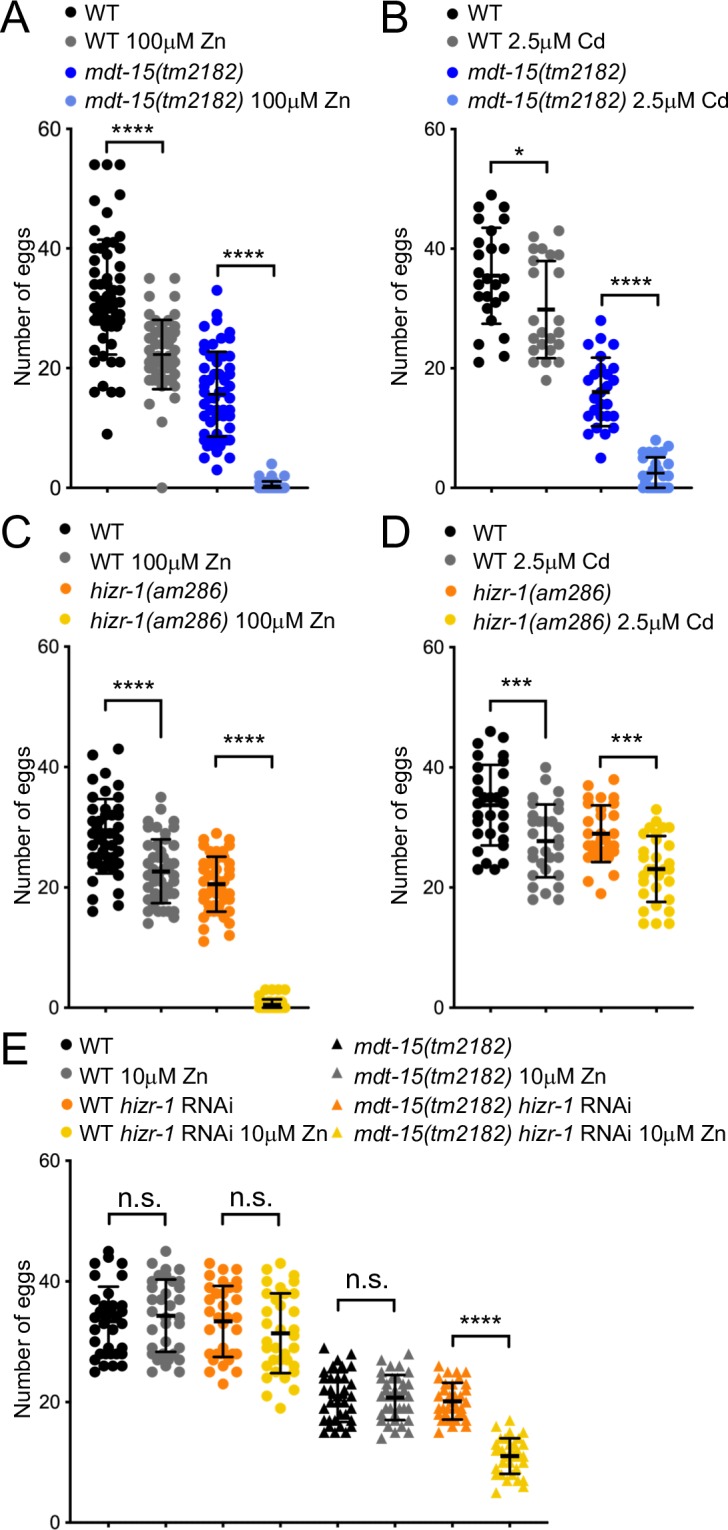
Loss of mdt-15 renders worms sensitive to cadmium and zinc.[A] The graph shows the average number of eggs laid over a 24-hour period by WT worms and mdt-15(tm2182) mutants grown on 0μM and 100μM zinc (Zn). Each dot represents progeny from an individual worm (WT 0μM Zn: n = 59; WT 100μM Zn: n = 56; mdt-15(tm2182) 0μM Zn; n = 57; mdt-15(tm2182) Zn: n = 51; from 3 independent repeats). Error bars: standard deviation; statistical analysis: **** p < 0.0001, Two-way ANOVA, multiple comparisons; Tukey correction. [B] The graph shows the average number of eggs laid over a 24-hour period by WT worms and mdt-15(tm2182) mutants grown on 0μM and 2.5μM cadmium (Cd). Each dot represents progeny from an individual worm (WT 0μM Cd: n = 25; WT 2.5μM Cd: n = 23; mdt-15(tm2182) 0μM Cd: n = 26; mdt-15(tm2182) on 2.5μM Cd: n = 27; from 3 independent repeats). Error bars: standard deviation; statistical analysis: **** p < 0.0001, * p < 0.05, Two-way ANOVA, multiple comparisons; Tukey correction. [C] The graph shows the average number of eggs laid over a 24-hour period by WT worms and hizr-1(am286) mutants grown on 0μM and 100μM zinc (Zn). Each dot represents progeny from an individual worm (all groups n = 46; from 2 independent repeats). Error bars: standard deviation; statistical analysis: *** p < 0.001, **** p < 0.0001, Two-way ANOVA, multiple comparisons; Tukey correction. [D] The graph shows the average number of eggs laid over a 24-hour period by WT worms and hizr-1(am286) mutants grown on 0μM and 2.5μM cadmium (Cd). Each dot represents progeny from an individual worm (all groups n = 30; from 2 independent repeats). Error bars: standard deviation; statistical analysis: * p < 0.05, Two-way ANOVA, multiple comparisons; Tukey correction. [E] The graph shows the average number of eggs laid over a 24-hour period by WT worms and mdt-15(tm2182) mutants fed control or hizr-1 RNAi and grown on 0μM and 10μM zinc (Zn). Each dot represents progeny from an individual worm (all groups n = 34; from 2 independent repeats). Error bars: standard deviation; statistical analysis: **** p < 0.0001, Two-way ANOVA, multiple comparisons; Tukey correction.